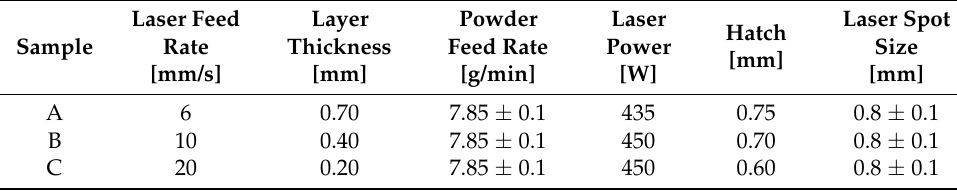
Table 2. Manufacturing parameters of the